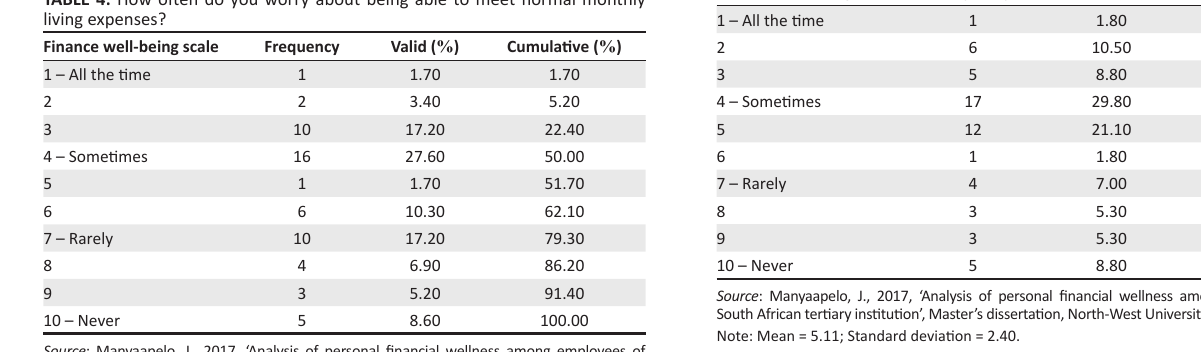
TABLE 6: How often does this happen to you? You want to go out to eat, go to a movie or do something else, and do not go because you cannot afford to. Finance well-being scale